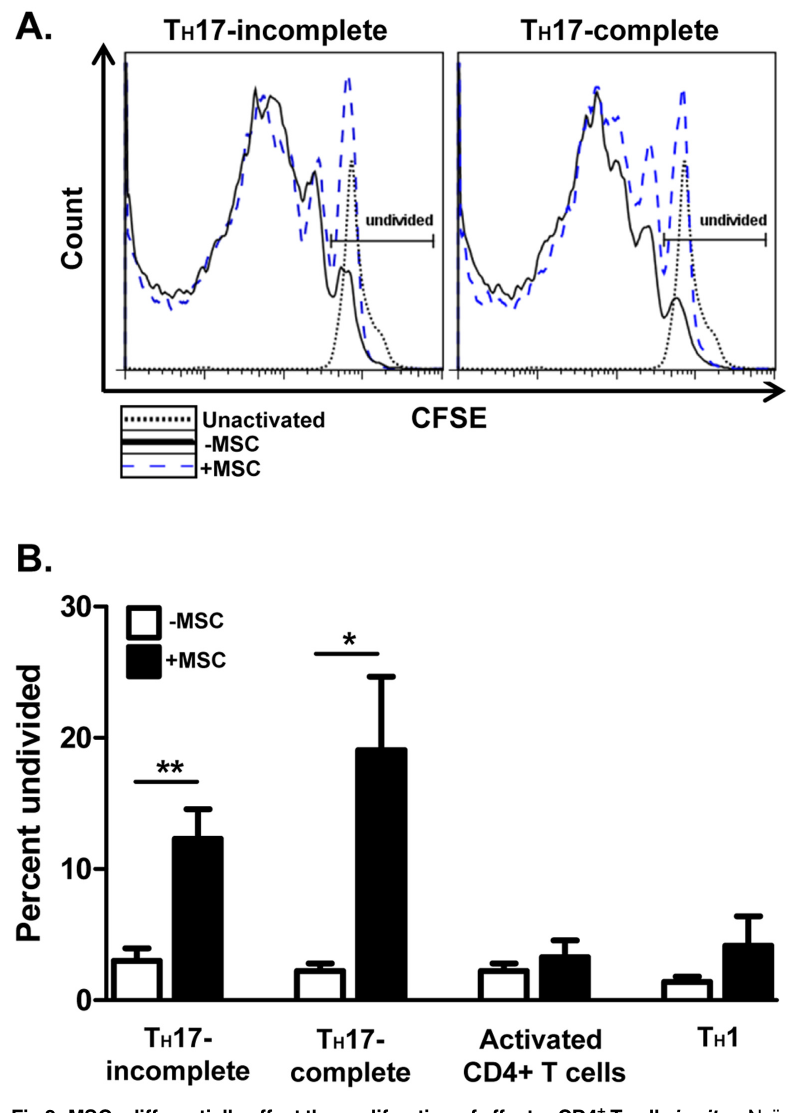
Fig 2. MSCs differentially affect the proliferation of effector CD4 + T cells in vitro . Na ï ve CD62L + CD4 + T cells were cultured in the absence or presence of MSCs at a T cell: MSC ratio of 4:1. CD4+ T cells were activated with plate-bound α -CD3 and soluble α -CD28 ± polarizing cytokines and neutralizing